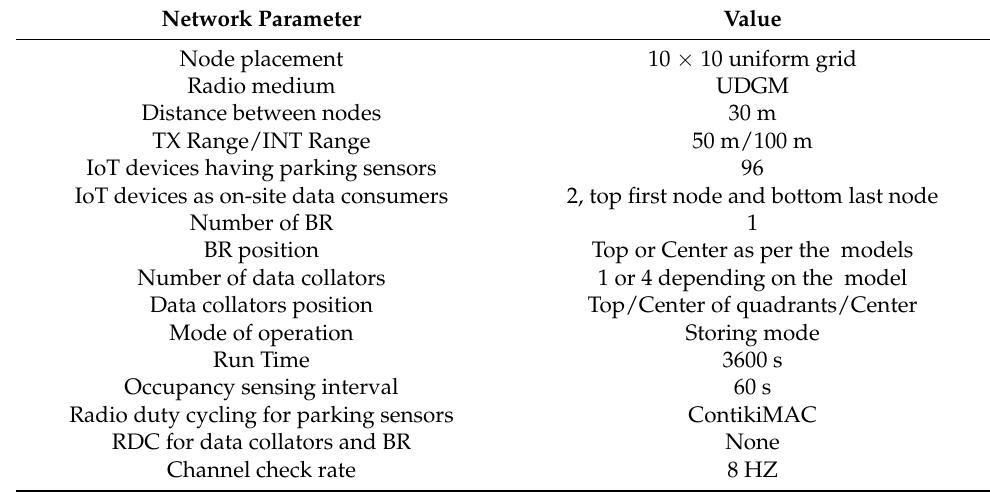
Table 1. Configuration parameters for the simulation